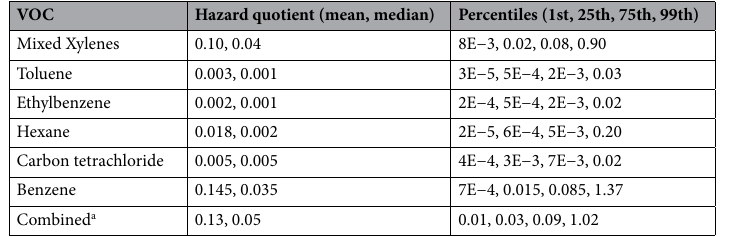
Table 6. Non-cancer risk hazard quotients for VOCs with a corresponding reference concentration in the integrated risk information system. Hazard quotients ≥ 1 indicate excess risk.